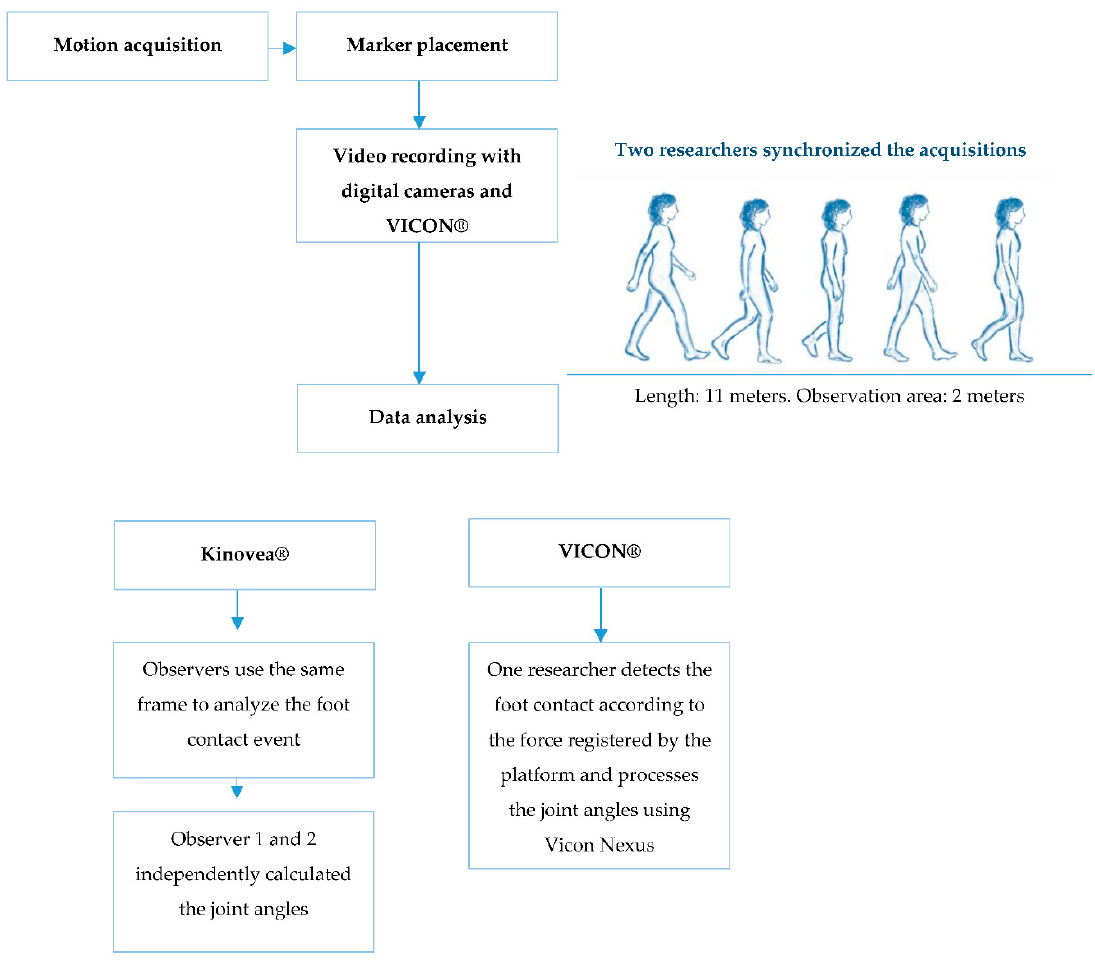
Figure 3. Diagram of the gait procedure and gait analysis .